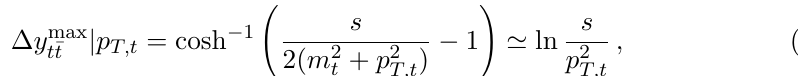
Figure 11 . Left: asymptotic leading-order forms for the ∆ y given in eq. (A.4), applied to the case of power-law dependence, n See text for